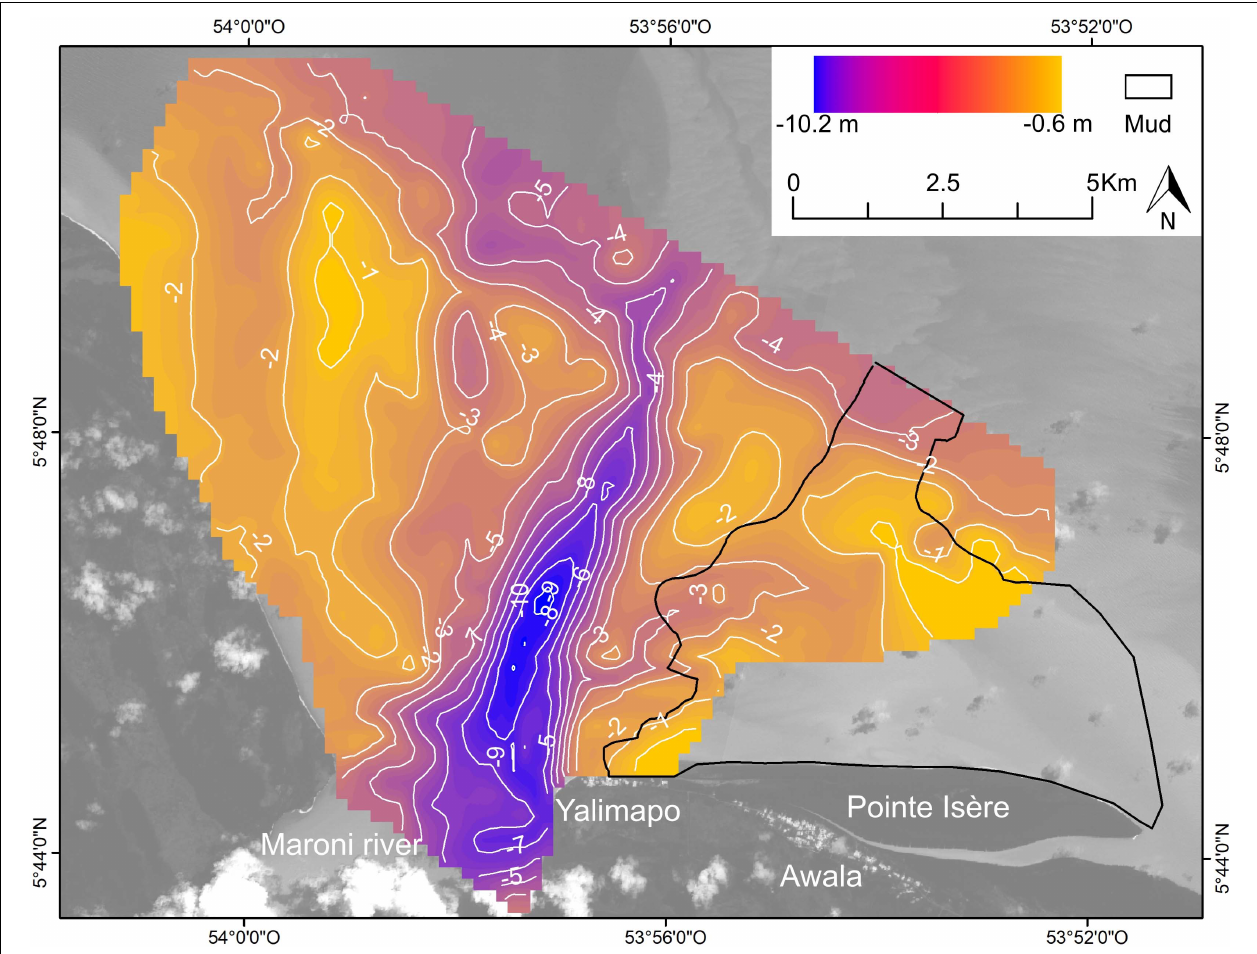
FIGURE 6 | Bathymetry of the Maroni estuary showing advanced sandy infill and a single estuarine channel. Mud (enclosed area) is associated with encroachment, from the east, of a mud bank over the sandy estuarine